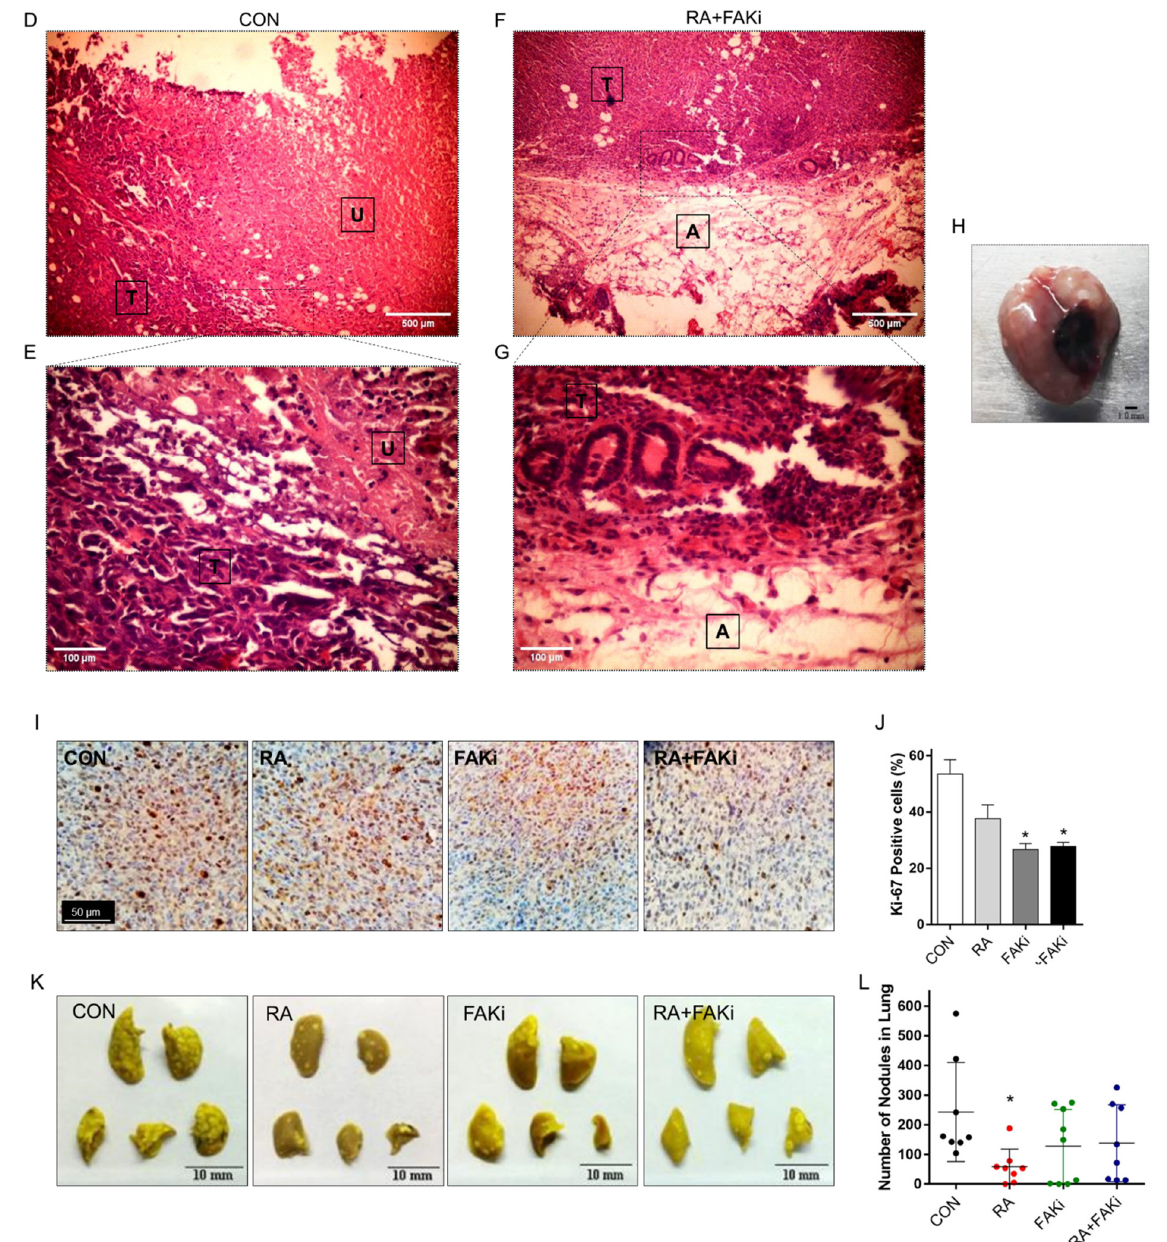
Figure 5. Combination of RA plus FAKi in a murine experimental model. An orthotopic tumor growth assay was performed inoculating LM3 cells pretreated or not with FAKi (1 µ M, 72 h) into BALB/c mice. Animals also received a subcutaneous silastic pellet containing RA (10 mg) or an empty pellet. ( A ) Tumor diameters were measured twice a week and used to calculate tumor volume. Each data point represents the mean ± SD, * = p < 0.05 vs. control, CON. ( B ) Representative images are shown. A dotted square indicates tumors. ( C ) Kaplan-Meier analysis of animal endpoint survival. Each color represents a different experimental group: control group (black), RA group (red), FAKi group (green), and RA + FAKi group (blue). ( D – H ) Effect of RA plus FAKi on histopathological features of LM3 orthotopic tumors. Tumors were fixed in 10% formalin and slides were stained with hematoxylin and eosin (T: Tumoral tissue, U: Ulcerated tissue, and A: Adipose tissue). ( D , F ) are images acquired at 100x magnification. ( E,G ) are the same sections with a 400 × magnification. ( H ) Representative image of an ulcerated tumor. ( I , J ) Images and the percentage of positive Ki-67-mammary tumor of LM3 cells compared to the control, CON; for each experimental condition are shown. * = p < 0.05 vs. control, CON. ( K , L ) An experimental metastasis assay was performed by